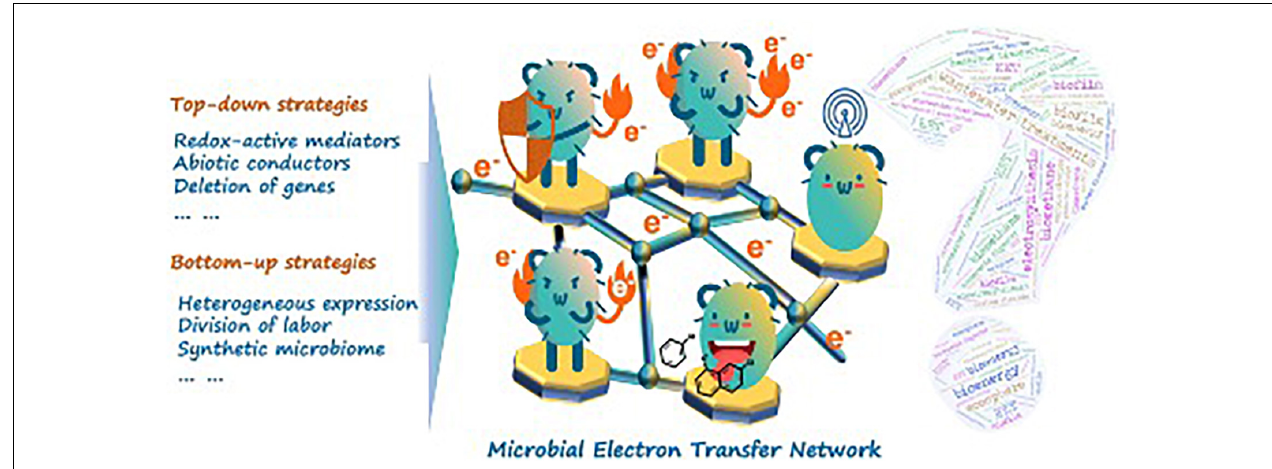
FIGURE 1 | METN development for next-generation environmental